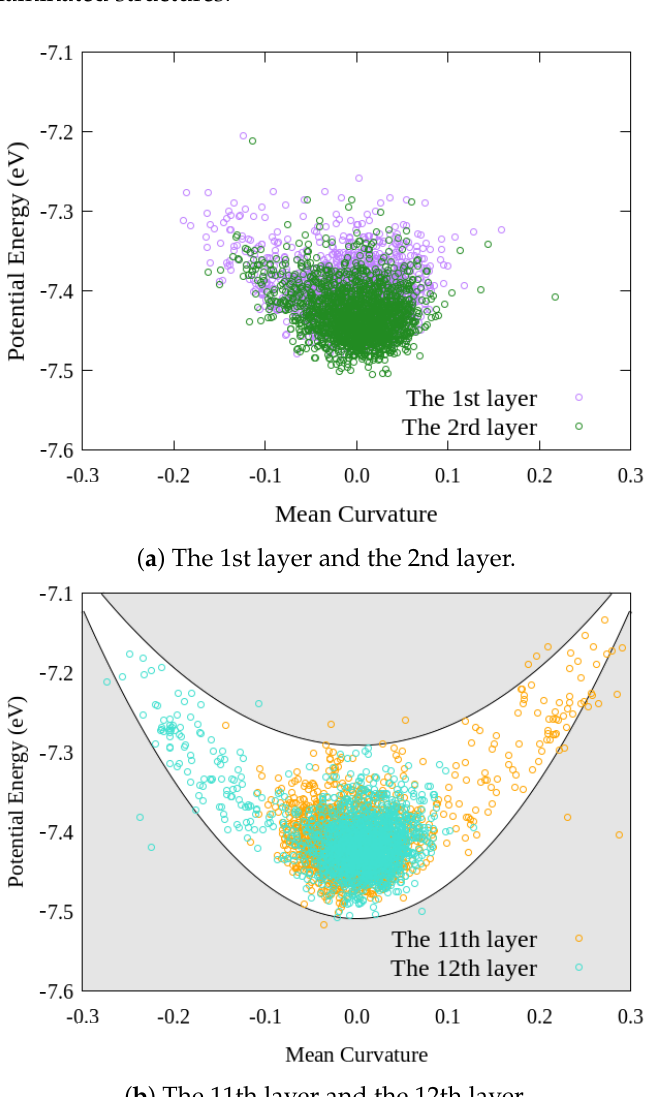
Figure 15. Potential energy and mean curvature of armchair graphite under compression ε =